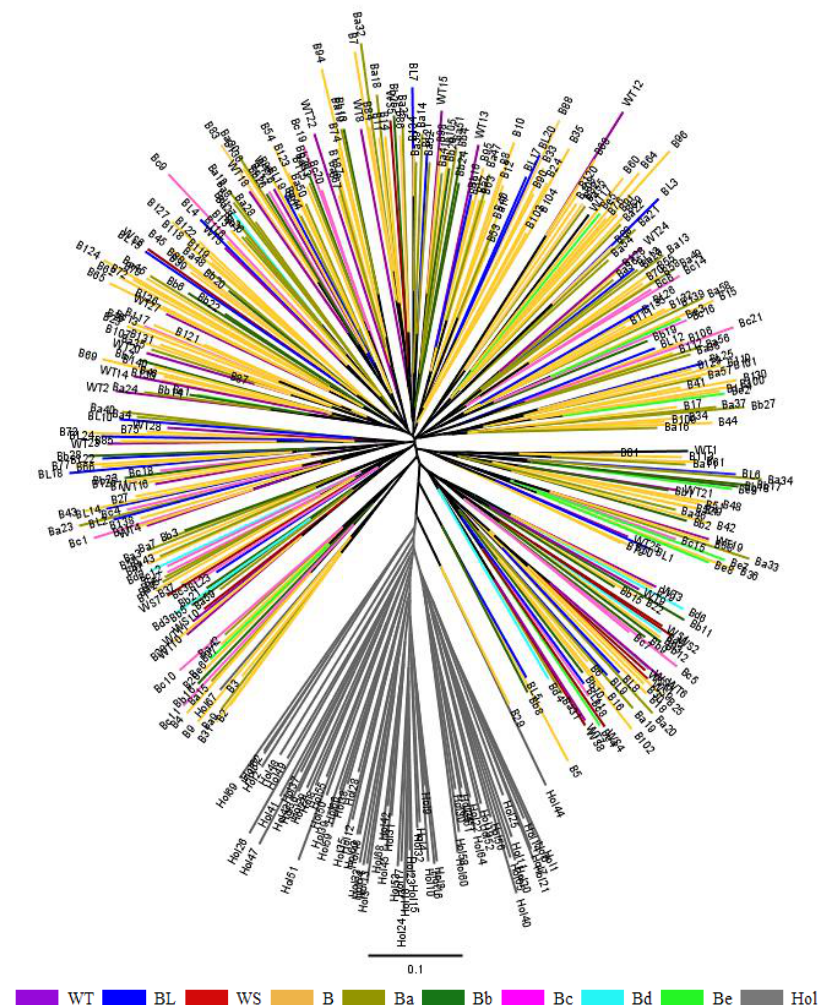
Figure 3. Neighbor-joining (NJ) dendrogram using D A genetic distance within the individuals of 10 populations grouped according to phenotypic characteristics. WT = White coat mixed with brown, BL = Black coat mixed with brown, WS = White spotted coat separated with brown, B = Hanwoo cattle with a cuticolor nose and pure brown coat, B (a to e): a-e represent different degree of nose pigmentation with “a” being the lightest and “e” the darkest, Hol = Holstein animals utilized as dairy cattle in